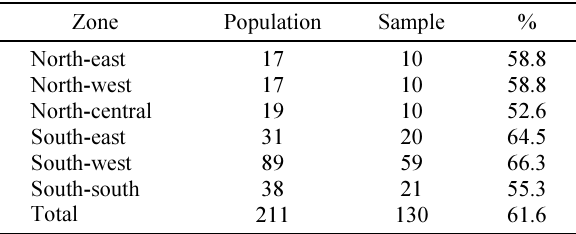
Table 1. Distribution of the study sample among the six geo-political zones in